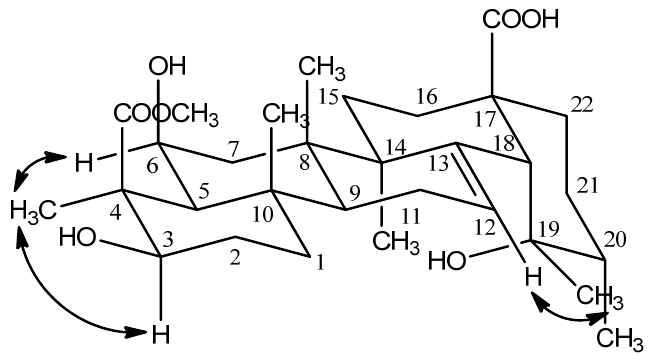
Figure 3. Selected NOESY correlations of compound 1